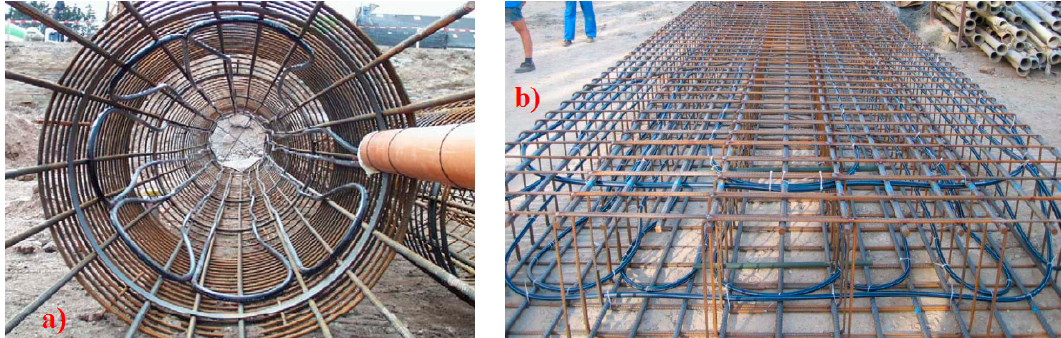
Figure 4. An example of an energy pile, ( a ) the interior of the pile reinforcement with arranged pipes [53], ( b ) pipe arrangement in a reinforcing structure (slurry wall) [54].